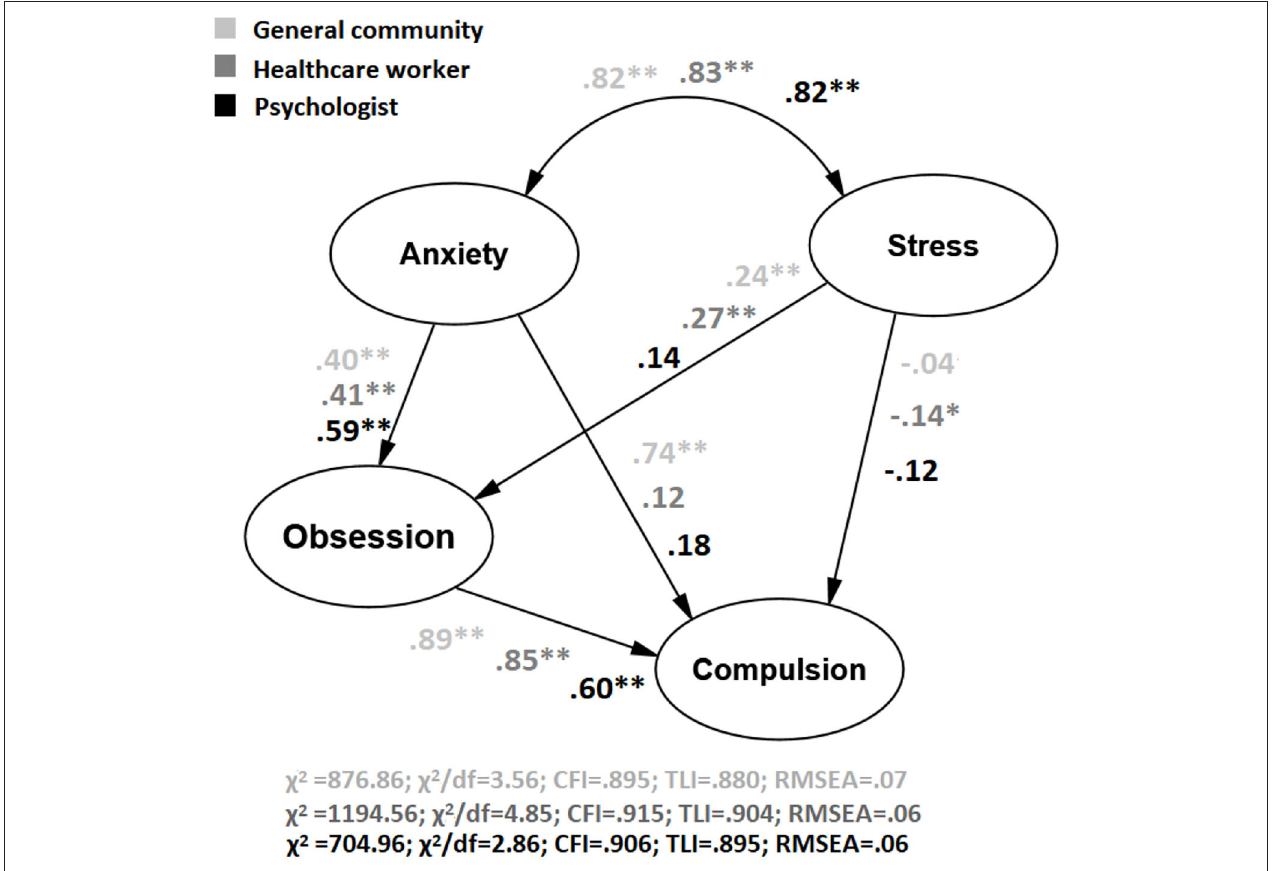
FIGURE 2 | Structural equation model testing an adapted model from Pauls et al. (2014) on Anxiety, Depression, and OCD across groups under study between the first wave and the second wave in Spain. * p < 0.05, ** p <